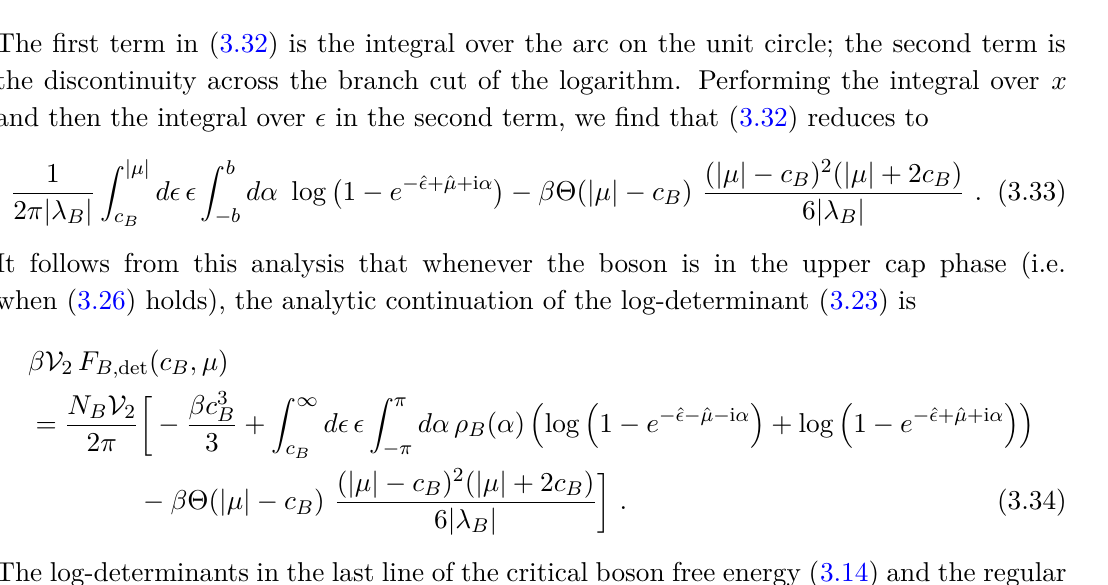
Figure 7 . Bosons in the upper cap phase: branch point is at z = + e ˆ (cid:15) −| ˆ µ | and is denoted by the black dot on the positive real axis. Dashed curve is the unit circle. Orange curve is the contour (counterclockwise) over which the holonomy is integrated over in this phase. Red line is the branch cut for the logarithm appearing in the bosonic free